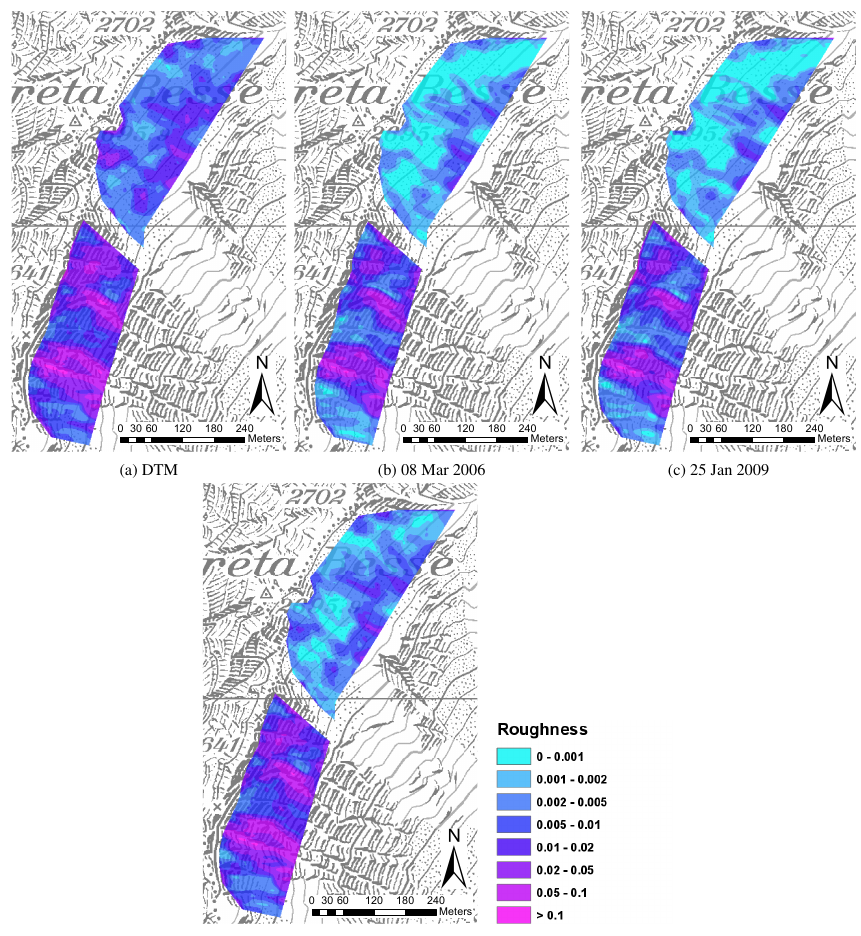
Fig. A7. Surface roughness of summer terrain and winter terrain at a scale of 25m in basins CB1 and CB2. Pixmaps © 2013 swisstopo (5704 000 000).